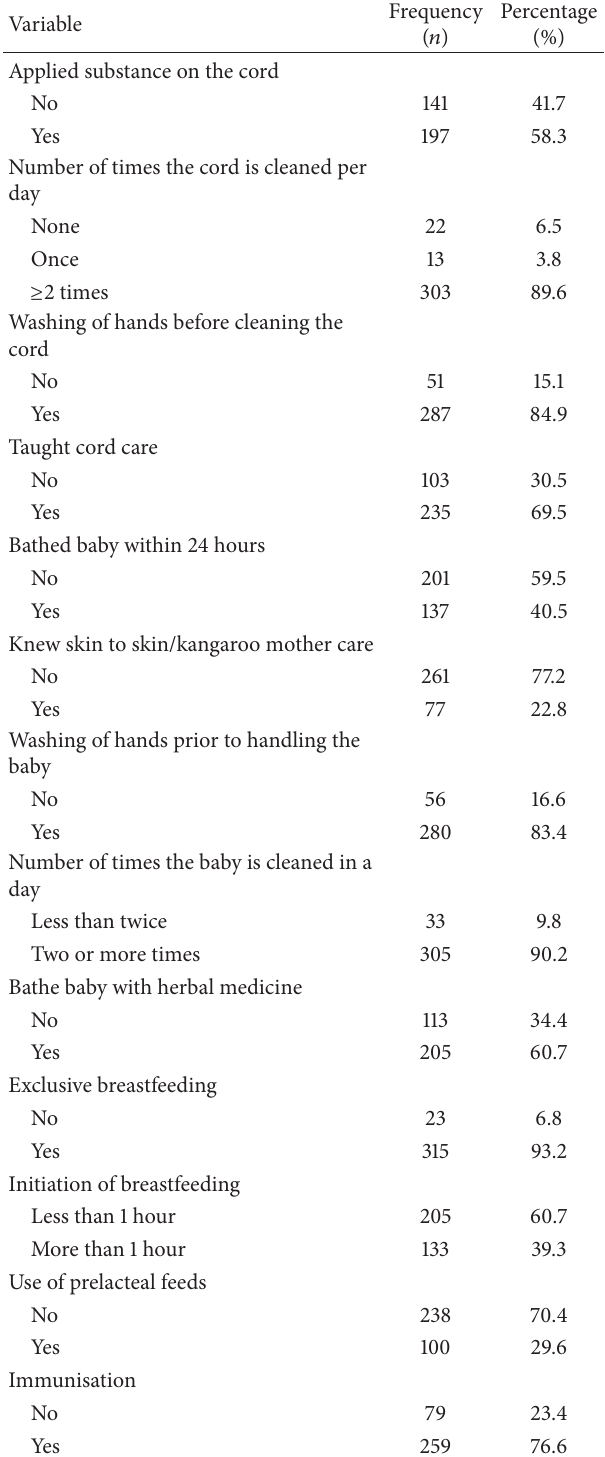
Table 2: The newborn care practices of 338 mother-infant dyads in Kampala District, Uganda,